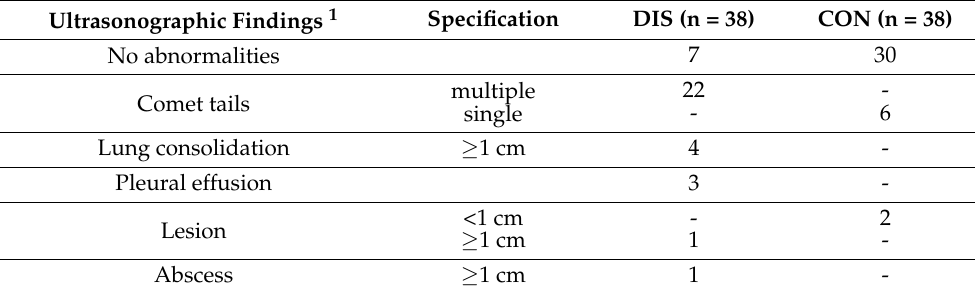
Table 3. Results of the thoracic ultrasonography in 76 dairy calves. Data for calves classified as diseased with bovine respiratory disease (DIS) and for clinically healthy control calves (CON) are